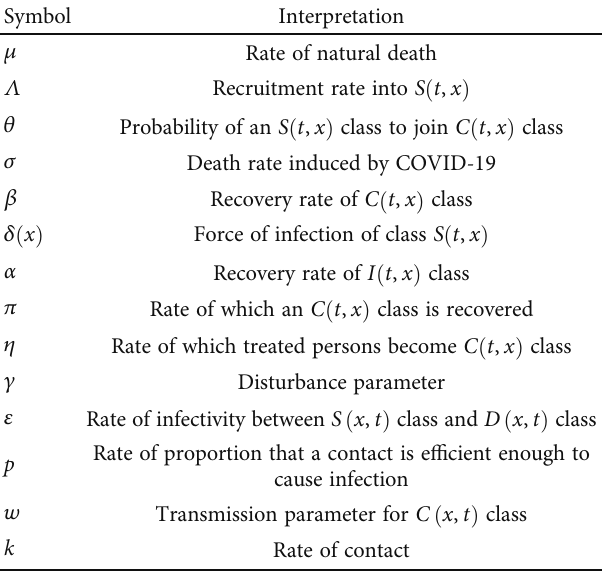
Table 1: Parameters of the considered